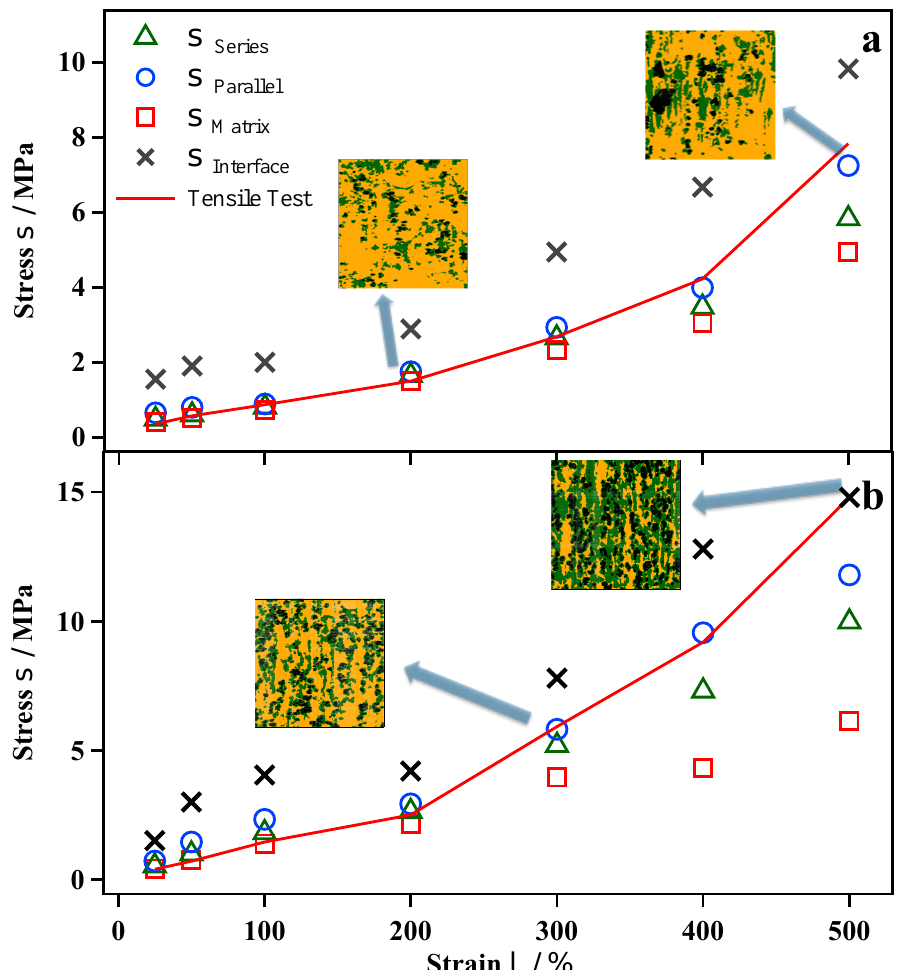
Figure 5. Comparison of macroscopic tensile data (red line) and PeakForce QNM AFM results (point) based on series and parallel model discussed in the text for stress of CB (4.9%, 10 phr)/IR ( a ) and CB (13.2%, 30 phr)/IR ( b ) as a function of the elongation. Because the CB does not actually carry the stress, it is reduced to a two-phase model here. The black area is CB, the yellow area is IR rubber, and the green area is the